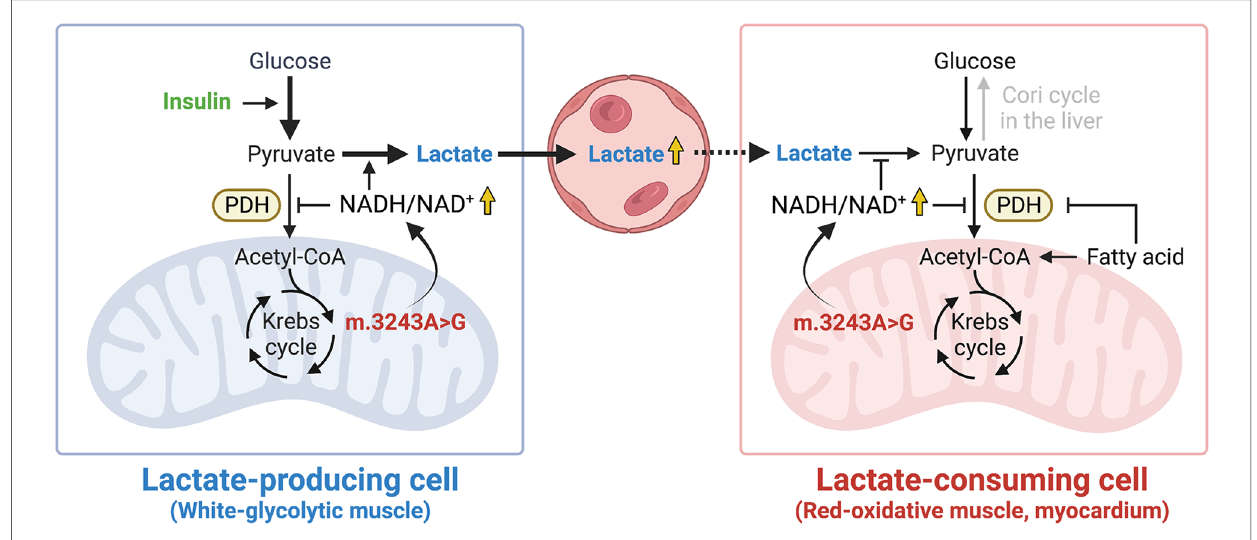
FIGURE 2 A schematic hypothesis. High NADH/NAD + ratio induced by mtDNA 3243A>G mutation promotes the reduction of pyruvate to lactate in lactate- producing cells while it inhibits the oxidation of lactate to pyruvate in lactate-consuming cells. The illustration was created with BioRender.com. NADH, reduced nicotinamide adenine dinucleotide; NAD + , oxidized nicotinamide adenine dinucleotide; PDH, pyruvate